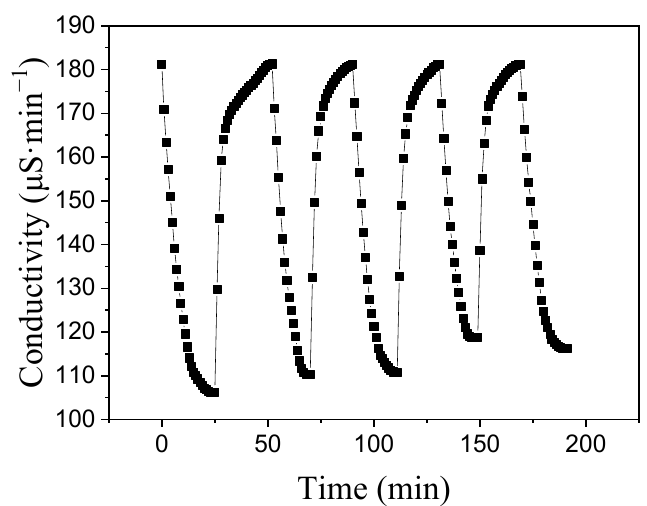
Figure 5. Regeneration properties of ACA electrodes.